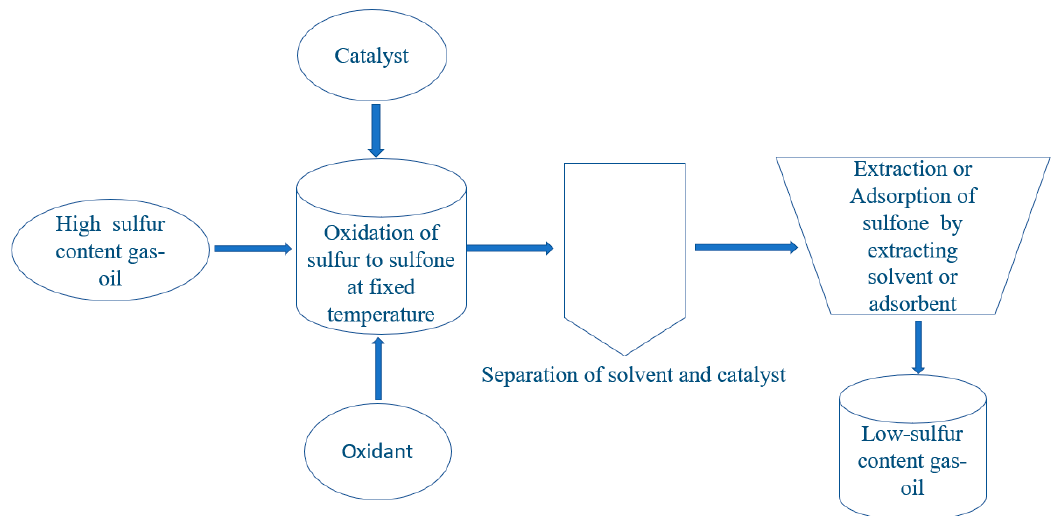
Figure 3. Schematic representation of sulfur removal in the oxidative desulfurization process.